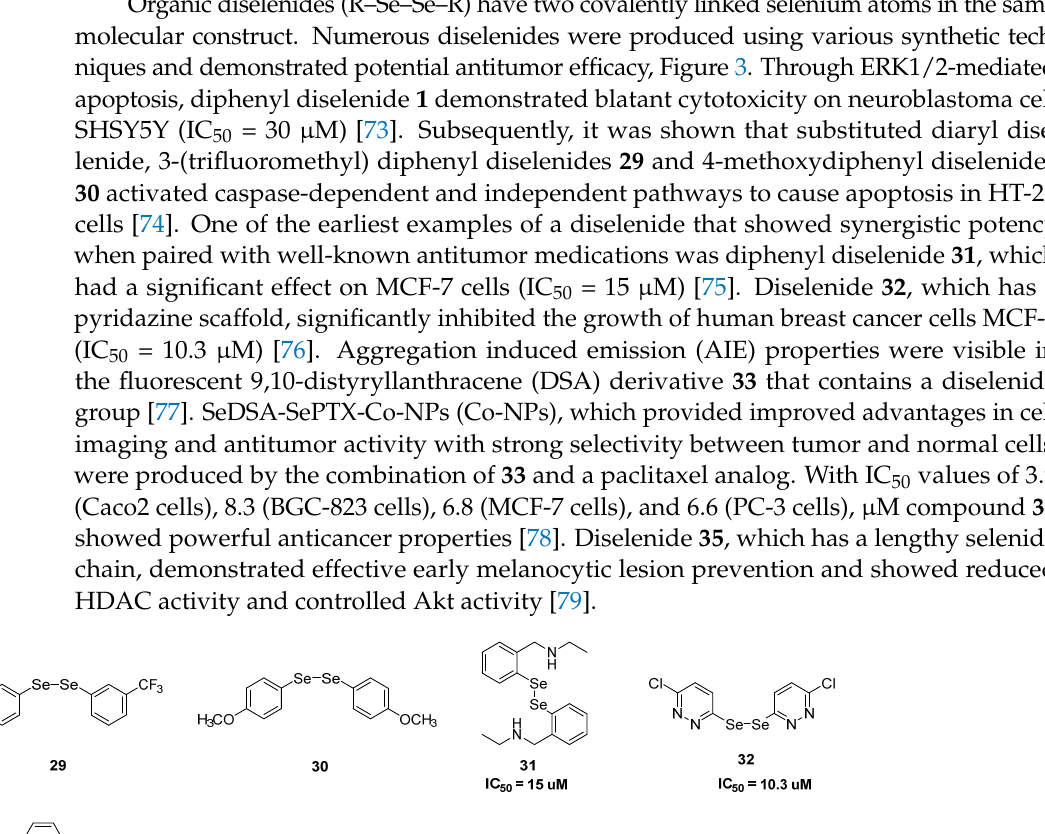
Figure 2. Structural representation of peptide-based selenium-containing compounds ( 17 – 19 ) [56– 60], ethaselen ( 20 ) [62], and selenides ( 21 – 28 ) [65–72] for anticancer activity and corresponding IC 50 values.